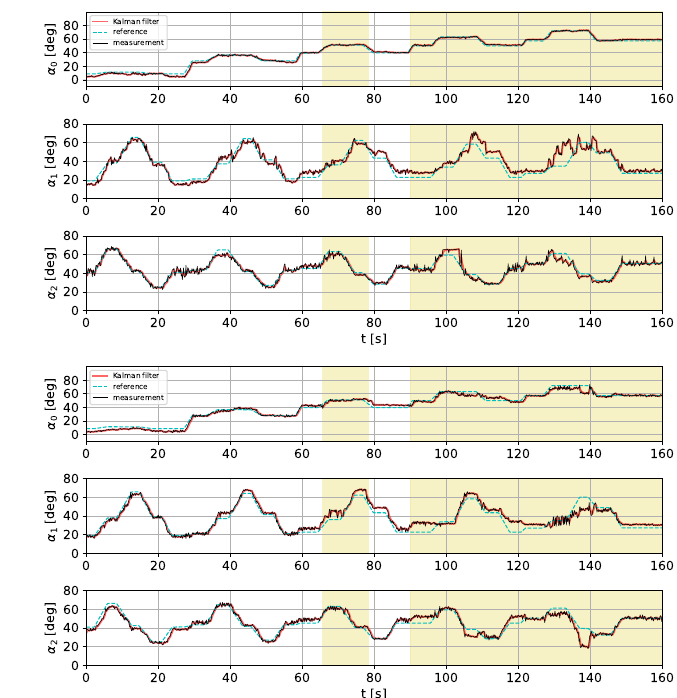
Figure 11. Comparison of the angle prediction accuracy for graph fitting and sparse CNN on the testing data set, learned on the image from the left camera. The shaded area indicates that the robotic arm is in front of the camera.